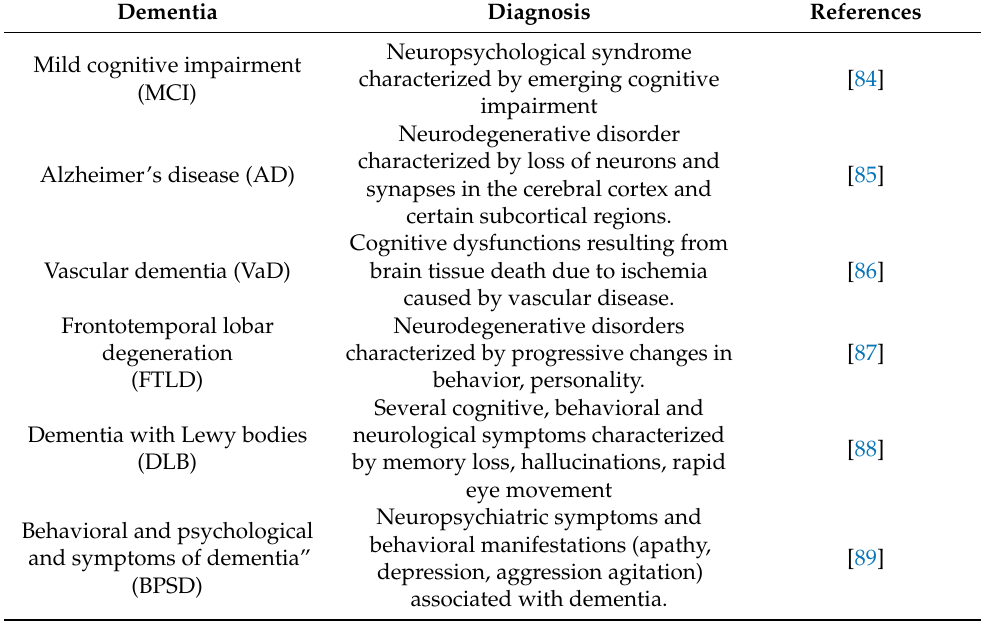
Table 1. Clinical studies on EGb761EGb 761 ® in patients with MCI, vMCI, neurocognitive deficit and